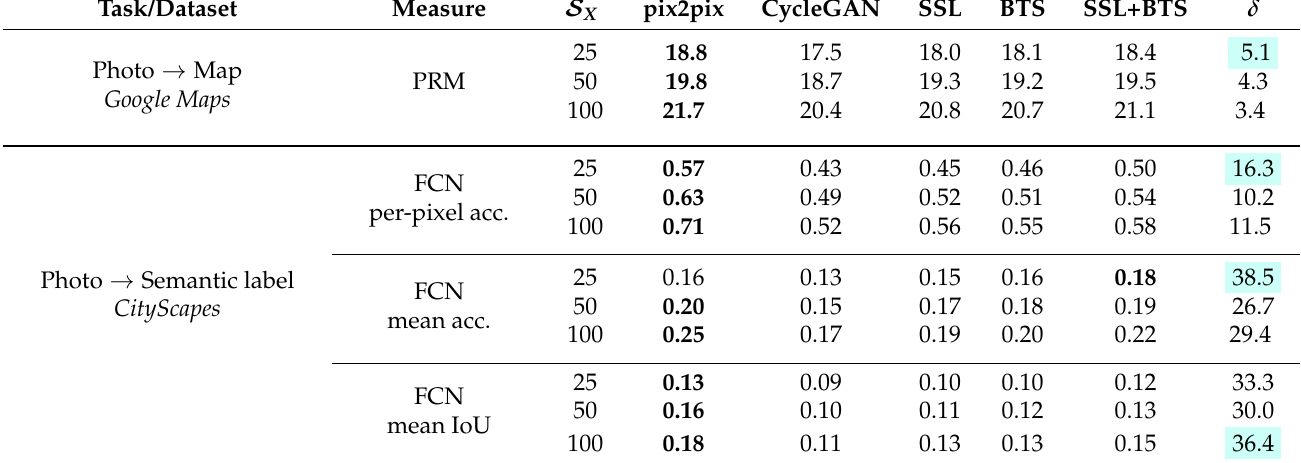
Table 2. Results of the second type of experiments. Performance of the proposed SSL+BTS was compared against unsupervised CycleGAN, and supervised pix2pix by using Perceptual Realistic Measure (PRM) for the ‘Photo → Map’ domain translation task, and by assessing image segmentation quality in the case of ‘Photo → Semantic label’ task. Relative improvement of SSL+BTS over CycleGAN is expressed by δ , while the respective datasets are listed in the